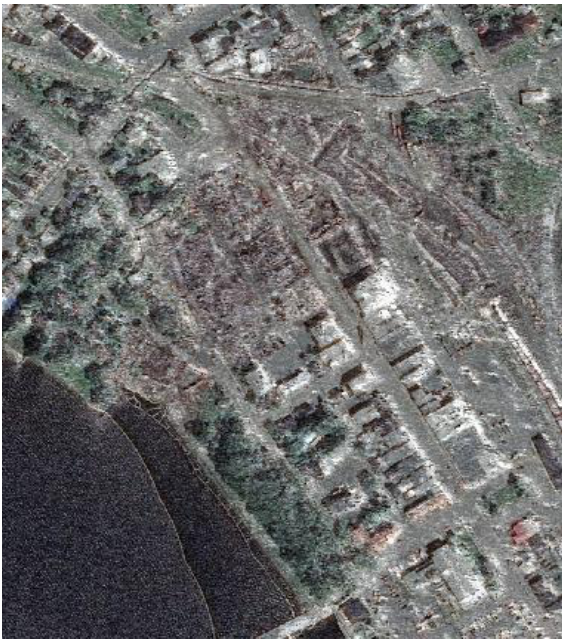
Figure 19. Both Pléiades and RADARSAT-2 were acquired on August 2, 2013 to generate this Fused RGB Composite. RADARSAT-2 Data and Products © MacDonald, Dettwiler and Associates Ltd. 2013. All Rights Reserved. RADARSAT is an official mark of the Canadian Space Agency . Pléiades data © CNES 2013, Distribution Airbus